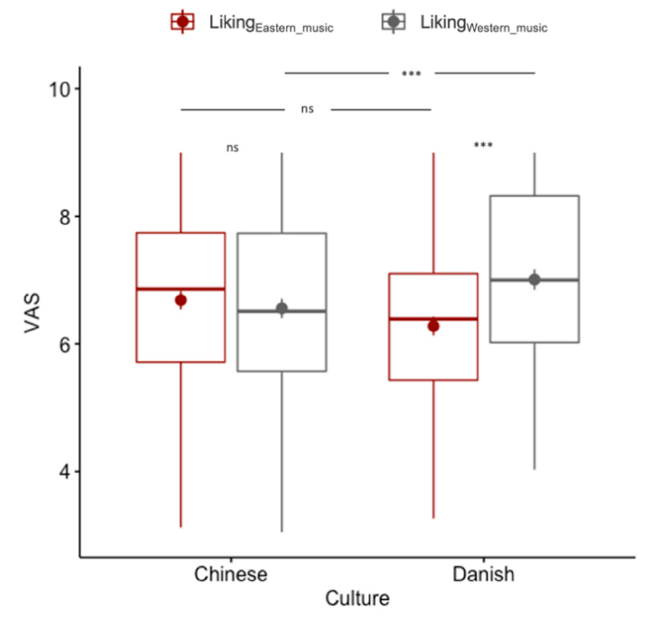
Figure 6. Boxplot of the liking ratings of the Eastern vs. Western music excerpts by Chinese and Danish participants. ns indicates no significance, *** indicates p < 0.001.